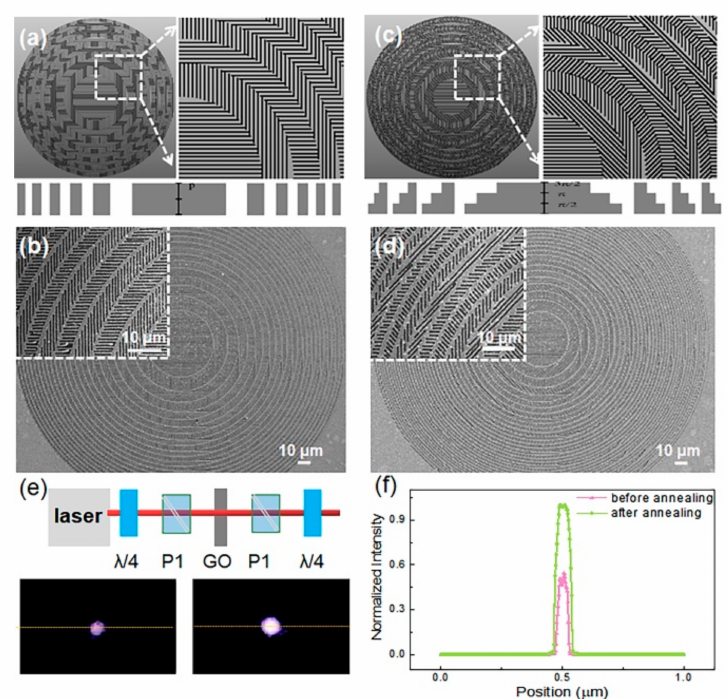
Figure 4. ( a , c ) Schematic diagram of the dielectric gradient metasurface lens with discrete level 4 and 8, respectively; ( b , d ) SEM image of the lens; ( e ) optical characterization and the intensity pattern at the focus before and after the thermal annealing experiment; ( f ) cross-sectional intensity profile at the focal plane along the dashed line in ( e ). All scale bars denote 10 µ